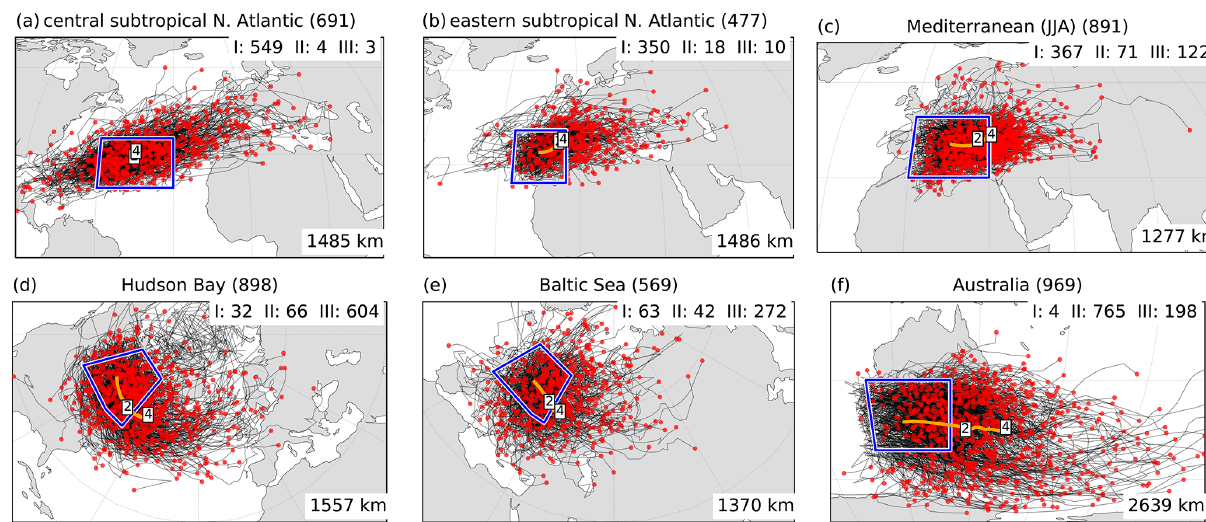
Figure 11. Same as Fig. 10 but for JJA and (a) central subtropical North Atlantic, (b) eastern subtropical North Atlantic, (c) Mediterranean, (d) Hudson Bay, (e) Baltic Sea, and (f) Australia.